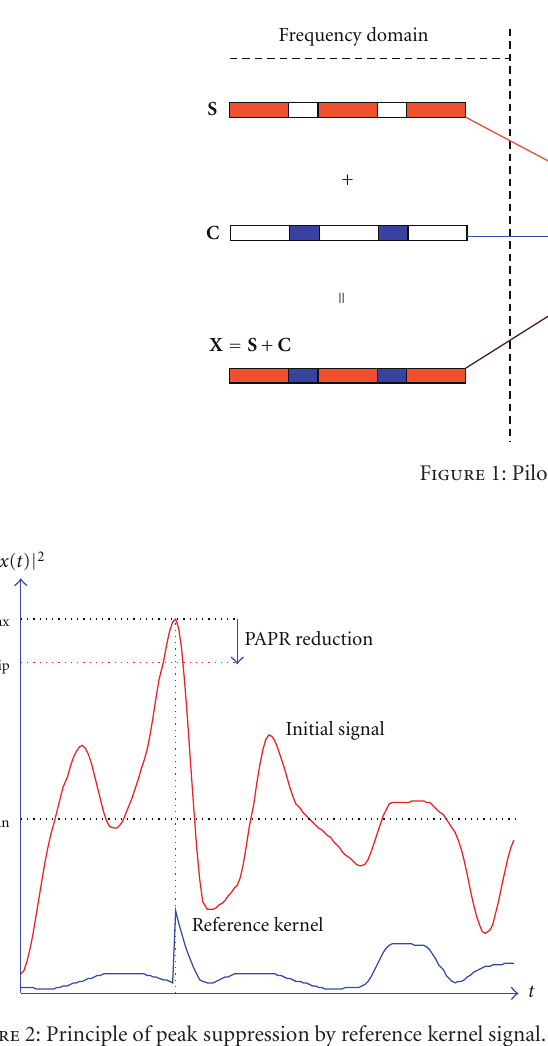
(4) if i < i max , the maximum iteration number, increase i by one and return to step (2); (5) terminate the iteration. The transmitted signal is obtained by: x (cid:11) = x + c ( i )